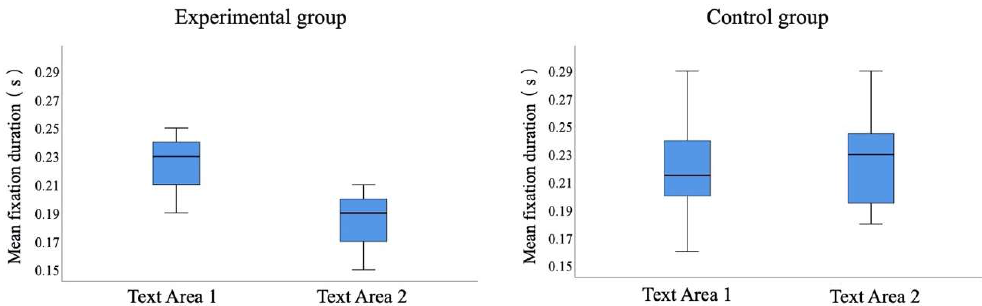
Figure 8. Statistical comparison of mean fixation duration on Text Areas 1 and 2 for the two groups. Table 3. The t -test results of mean fixation duration for the two groups.